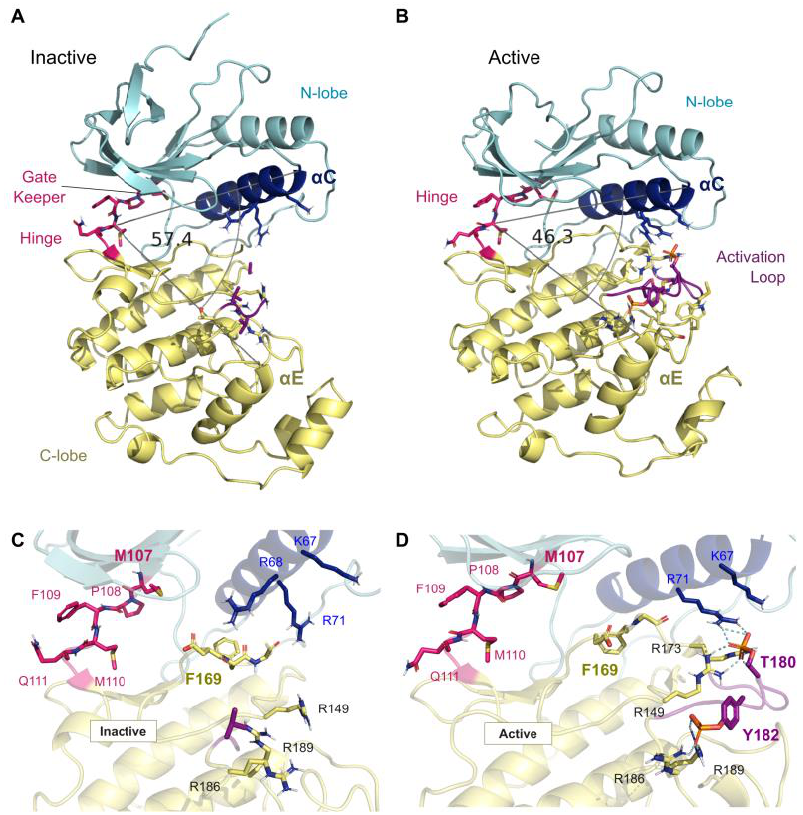
Figure 2. Overview of the p38 δ in the ( A ) inactive (PDB ID 4YNO) and ( B ) active states (PDB ID 4MYG). Highlighting the N- and C-lobes in cyan and yellow, respectively, the hinge region in pink, activation loop in purple, and the alpha-C helix in dark blue. It is noteworthy that the active state has a tighter conformation with a smaller angle between the alpha-C and E helices. Highlights of the ATP-binding of both the ( C ) inactive and ( D ) active, with the double phosphorylation, states. Depicting the DFG motif into the inwards conformation (DFG-in) and inactive (DFG-out), respectively. The gate-keeper residue (Met107) is depicted as sticks. In the DFG-out state, Phe169 moves out of the pocket and expose a new site which type-II inhibitors can explore and bind. The Phe169 (F169) side chain is shown in both figures. Structure p38 δ DFG-in (PDB ID 4EYM); structure p38 δ DFG-out. Image generated in